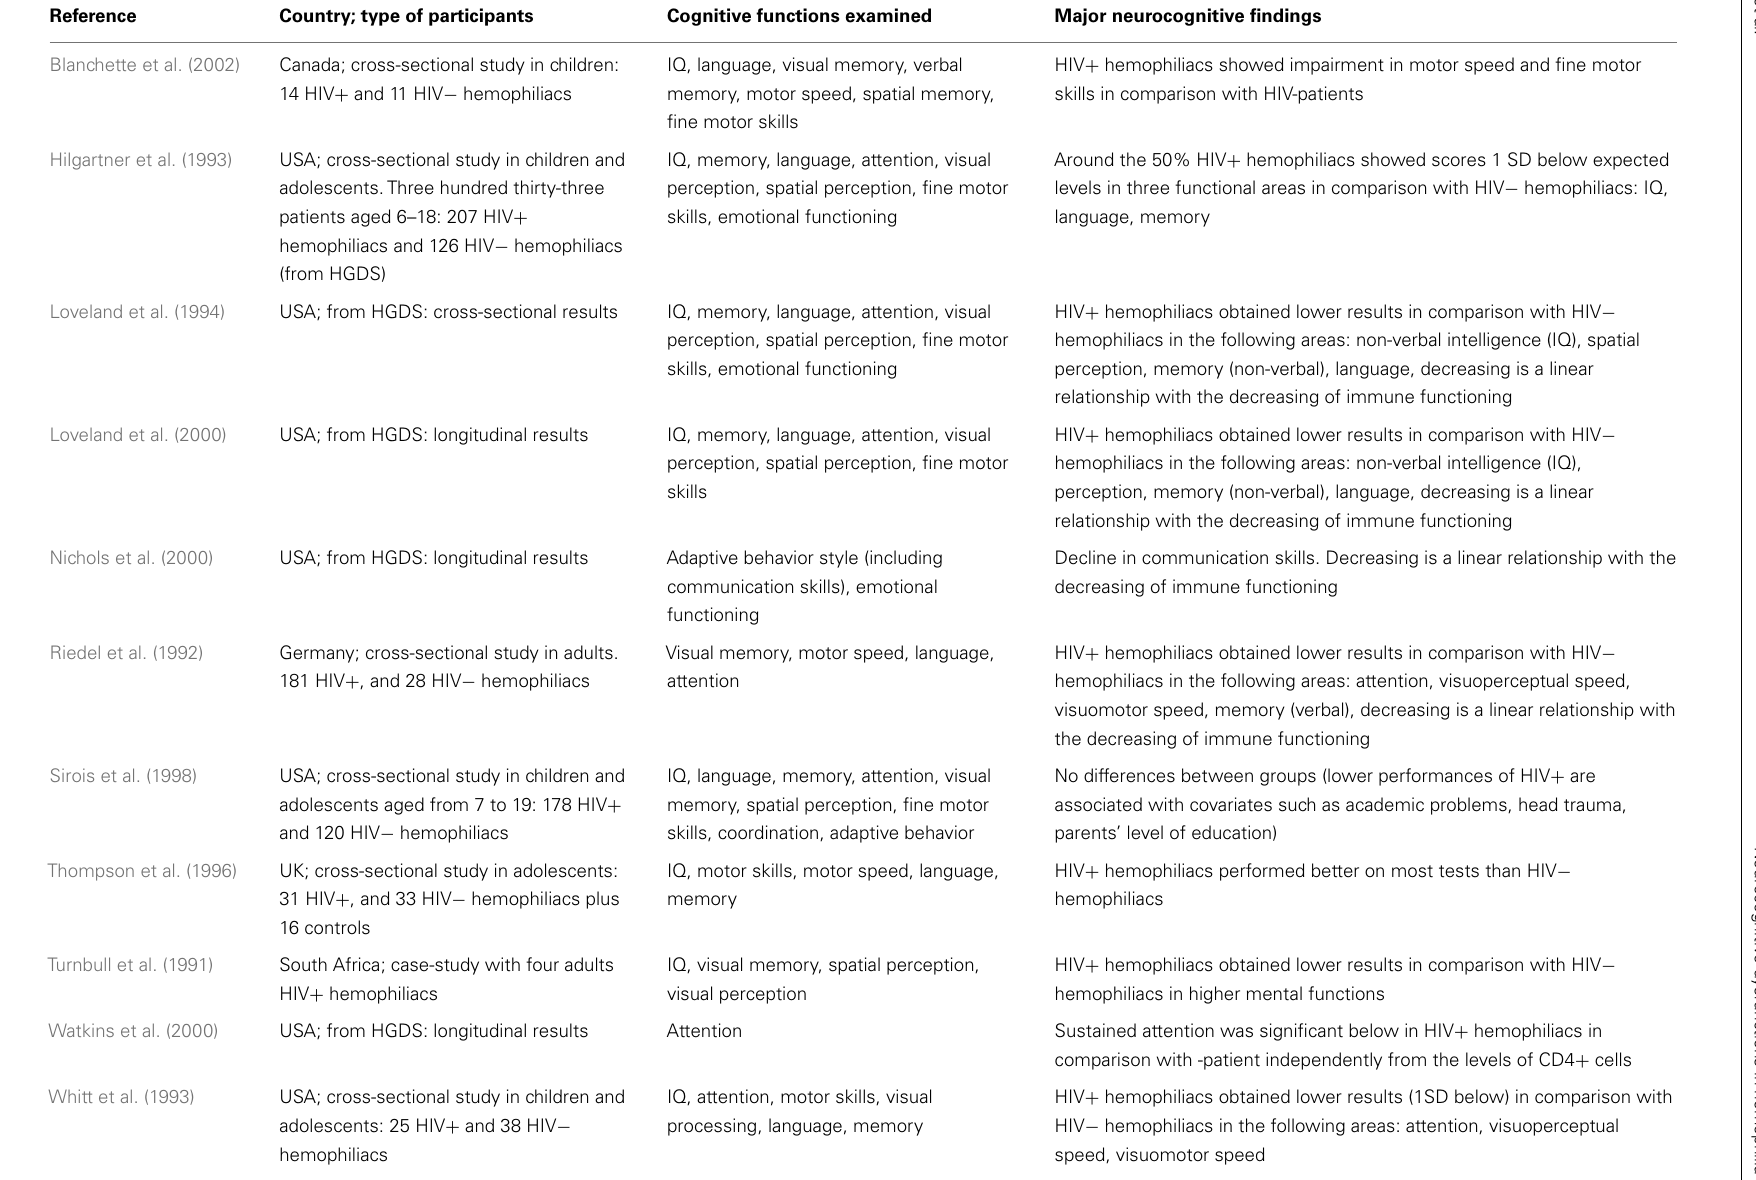
Table 1 | Listing of existing neuropsychological studies on hemophiliacs HIV + patients